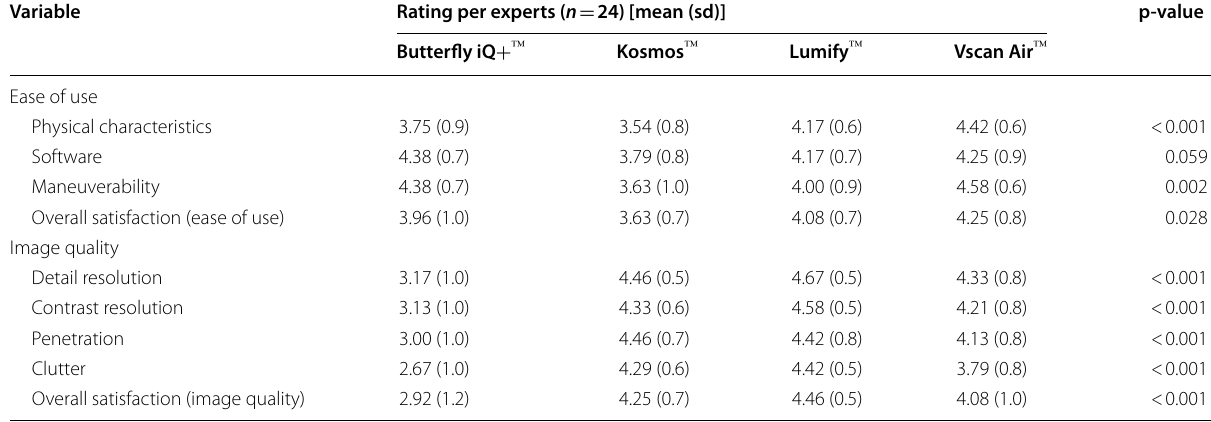
Ratings of 1–5 based on a Likert scale of agreement (5) or disagreement (1) p -values from Kruskal–Wallis rank sum test; < 0.05 indicates at least one device is statistically different from another device